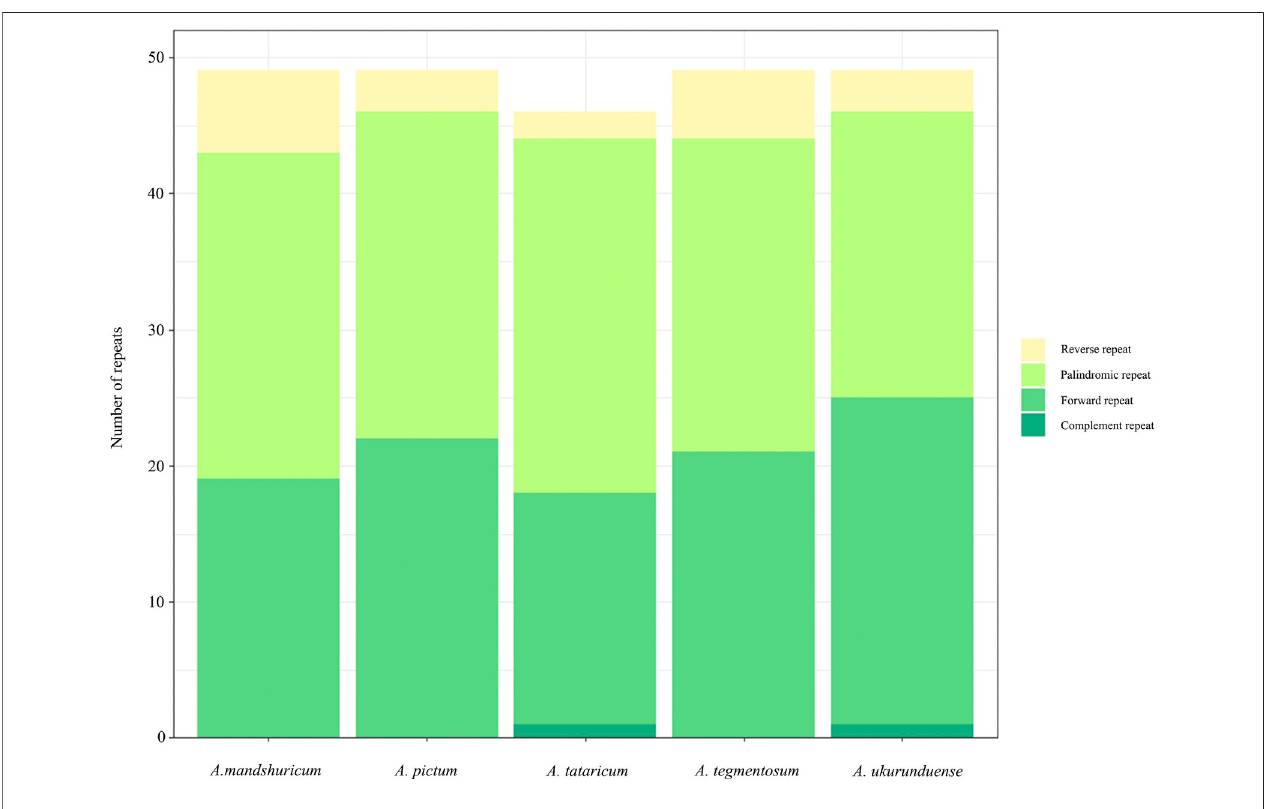
FIGURE 3 | Repeated sequences in fi ve Acer cp genomes.